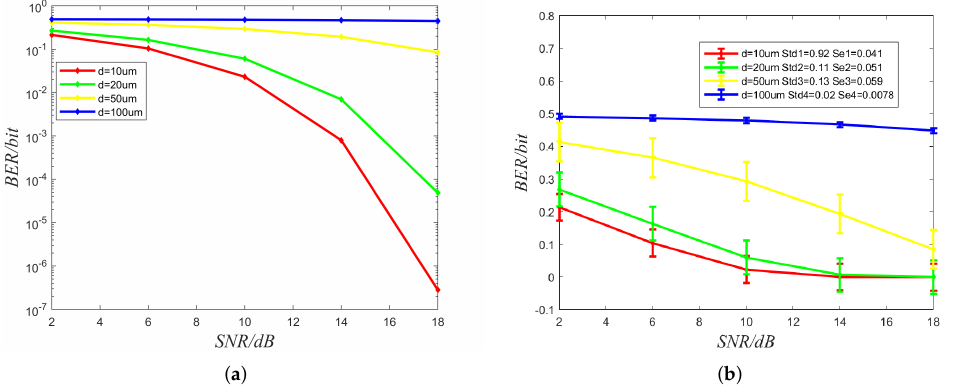
Figure 8. ( a ) Bit Error Ratio (BER) versus signal-to-noise ratio (SNR) with different distances. dB denotes the unit of SNR. ( b ) Std and Se denote standard deviations and standard error,